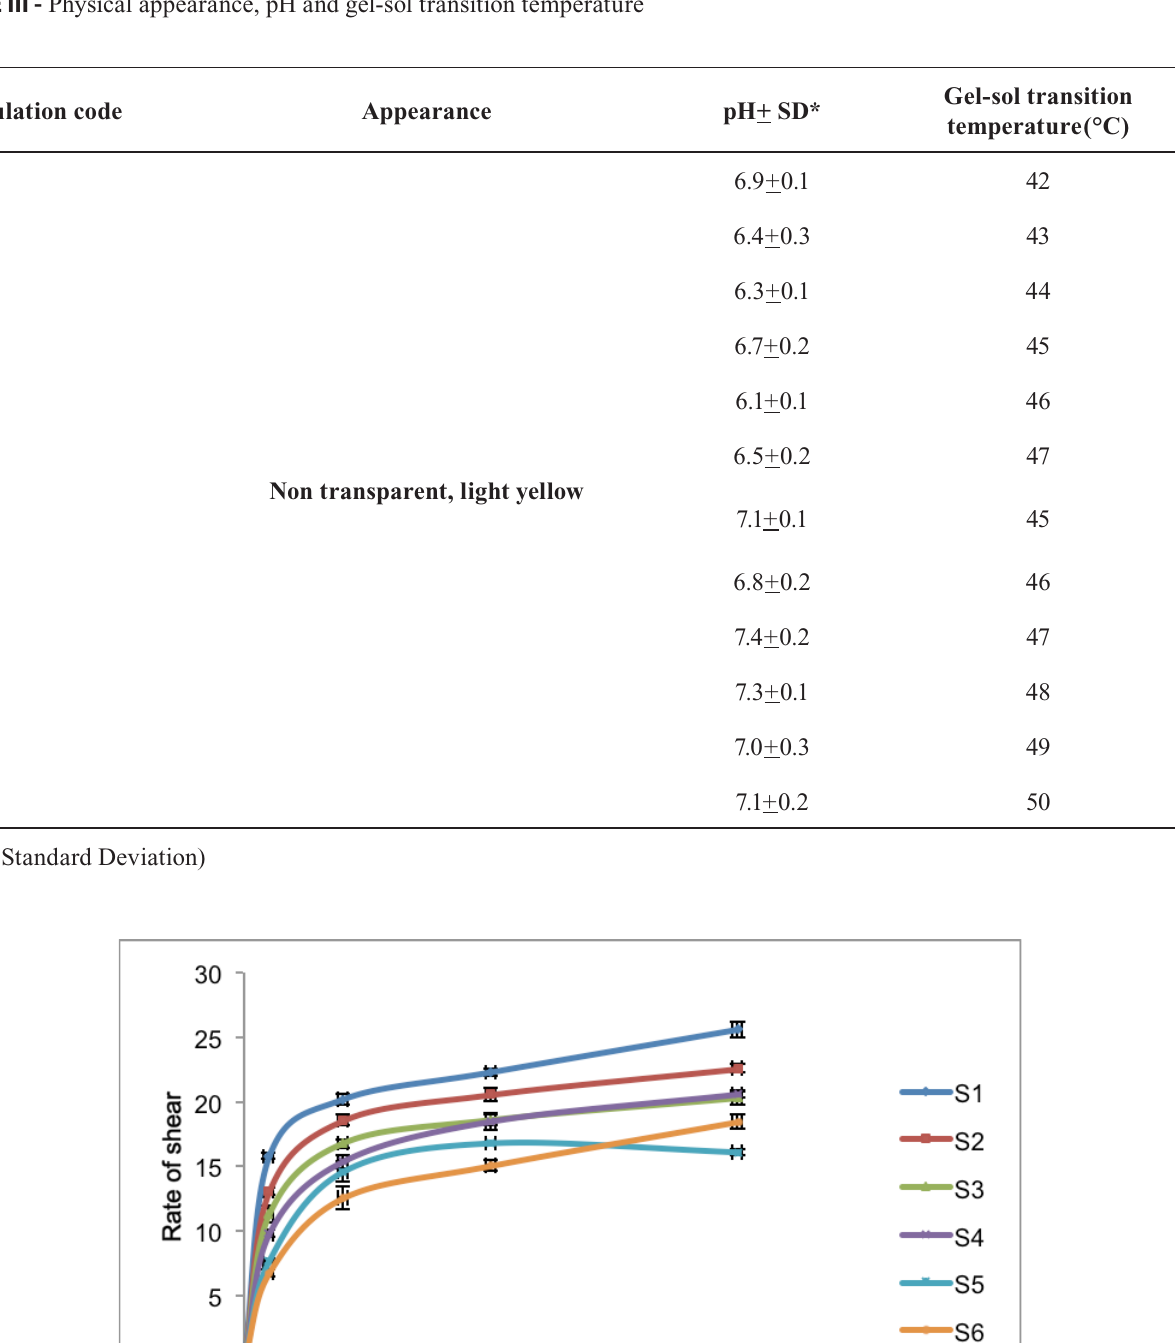
TABLE III - Physical appearance, pH and gel-sol transition temperature